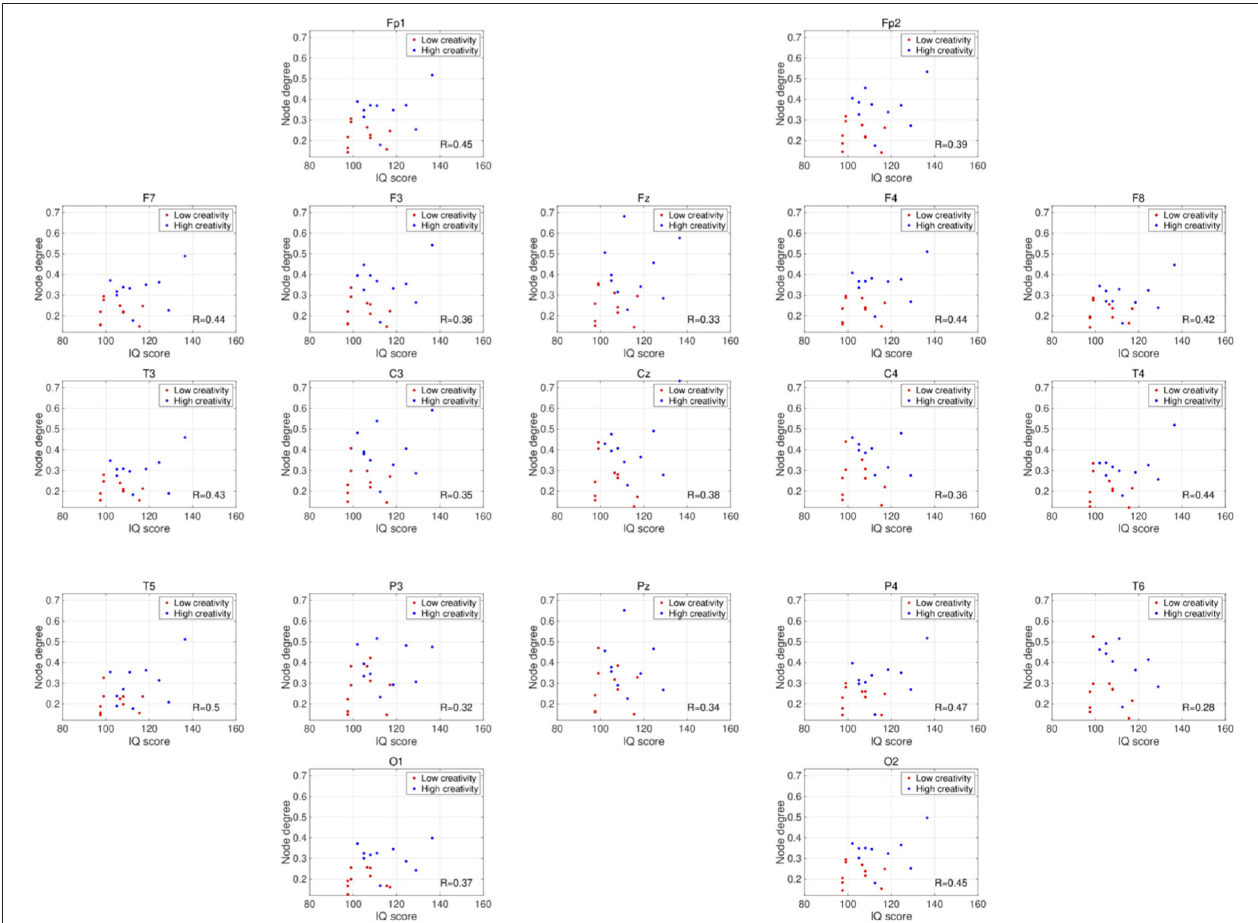
FIGURE 5 | Scatter plots showing the relationships between the node degrees calculated from the PLIs in the alpha band and IQ scores. R is the Pearson’s correlation coefficient. There are no electrodes with significant high correlations satisfying the FDR criteria q <